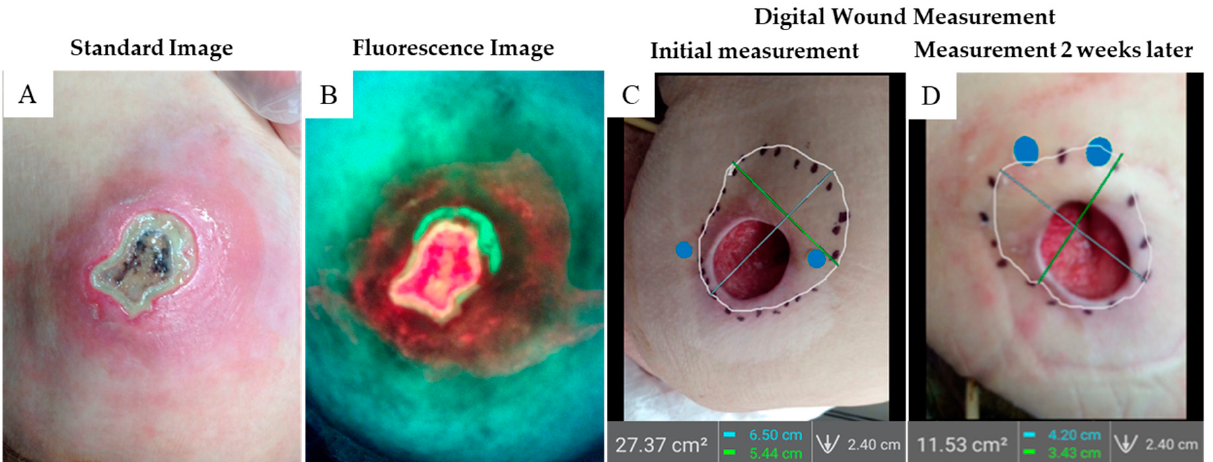
Figure 3. Case 2. This stage 4 pelvic pressure injury (6 cm 2 ) over the left ischium had developed necrotic tissue over the subdermal fascia and has a broad area of erythema in surrounding skin. ( A ) Three days before, wound appearance had been benign after debridement. ( B ) Autofluorescence reveals marked bacterial infestation in the wound bed and also alerted the clinician to extensive diffuse subcutaneous bacterial burden. ( C ) A digital wound measurement was obtained with the bacterial imaging device by placing 2 blue WoundStickers on either side of the wound assessing the tunneled area to 27 cm 2 ( D ). Three weeks later, digital wound measurement showed a dramatic reducing in wound size down to 11.5 cm 2 , a 60% reduction.